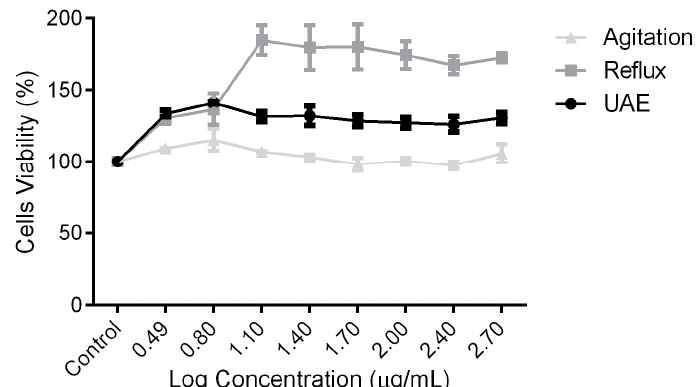
Figure 2. Cytotoxicity effect of C. papaya leaves extracts on the cell viability of HSF1184. ( A ): UAE, ( B ): reflux, ( C ): agitation. Results are expressed as the mean of three independent experiments.